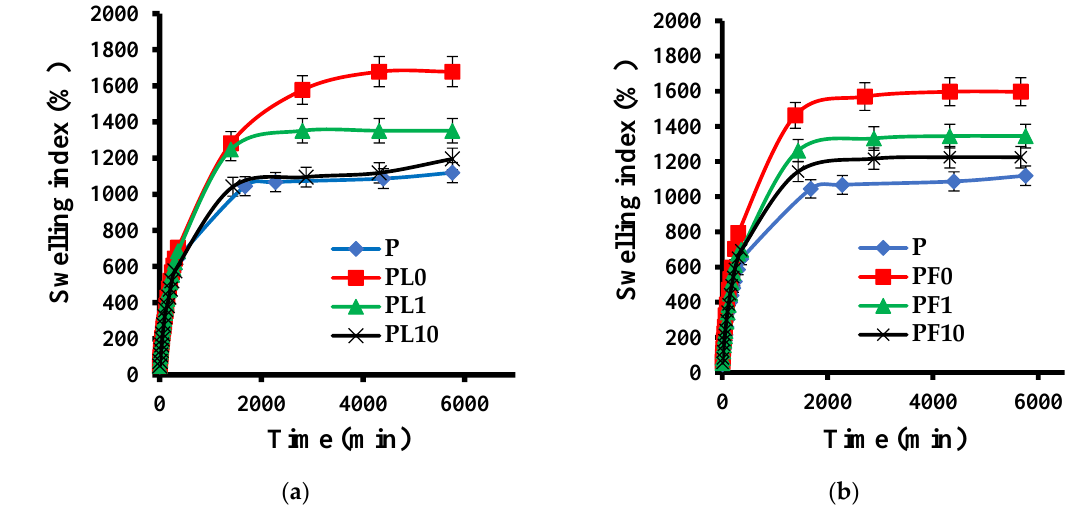
Figure 20. Effect of the concentration of the inorganic phase on the swelling index of hybrid hydrogels: ( a ) polyacrylamide/RM, ( b ) polyacrylamide/FeSiMn.